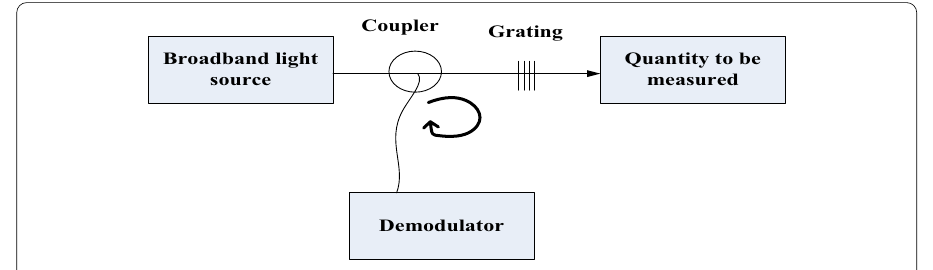
Fig. 1 Schematic diagram of fiber grating sensor detection